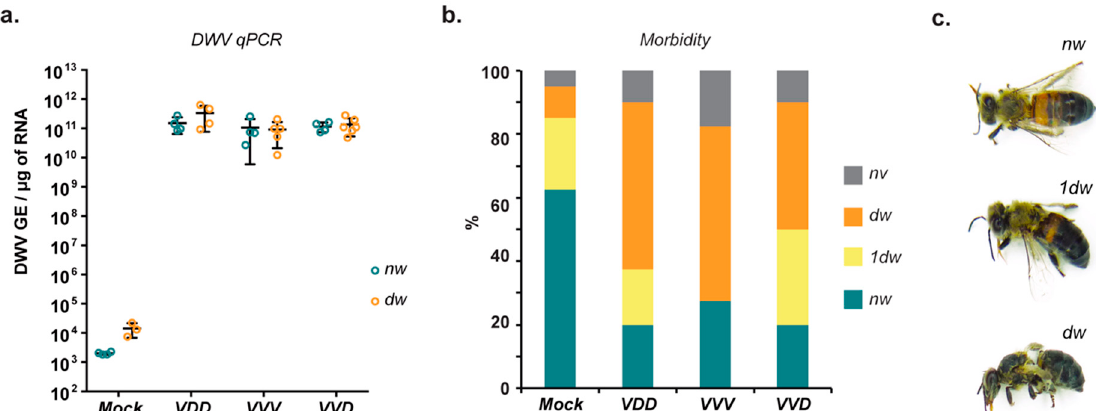
Figure 4. Morbidity of DWV variants in honey bee pupae. ( a ) RT-qPCR analysis of DWV levels in honey bees developed from pupae injected with the indicated virus variants and displaying normal (“nw”) or deformed wing (“dw)” phenotype; no significant di ff erence in DWV levels was found between deformed and non-deformed bees (Sidak’s multiple comparisons test, p = 0.1307 (VDD), p = 0.9975 (VVV), p = 0.9911 (VVD)); ( b ) Percentage of visually normal (“ nw ”), partially deformed (“1dw”), deformed (“ dw ”) and non-viable (“ nv ”) honey bees eclosed from pupae injected at the white-eyed stage with 10 2 GE of the indicated DWV variants ( n = 40 for each group); ( c ) Newly emerged honey bees with di ff erent phenotypes of morbidity: “nw”—non-deformed bee with fully unfolded wings; “1dw”—bee with only one normal wing; “dw”—bee with deformities in both wings. In the field non- Varroa transmission of DWV ( per os or vertically) results in predominantly asymptomatic (also referred to as covert) infection, with no apparent phenotypic deformities. We